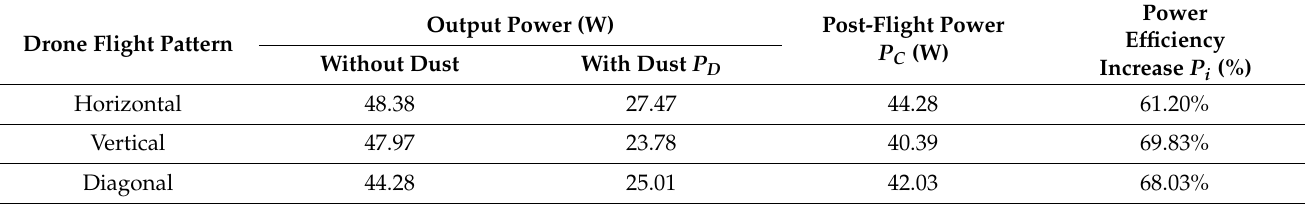
Table 4. Power analysis of different drone flight methods (50